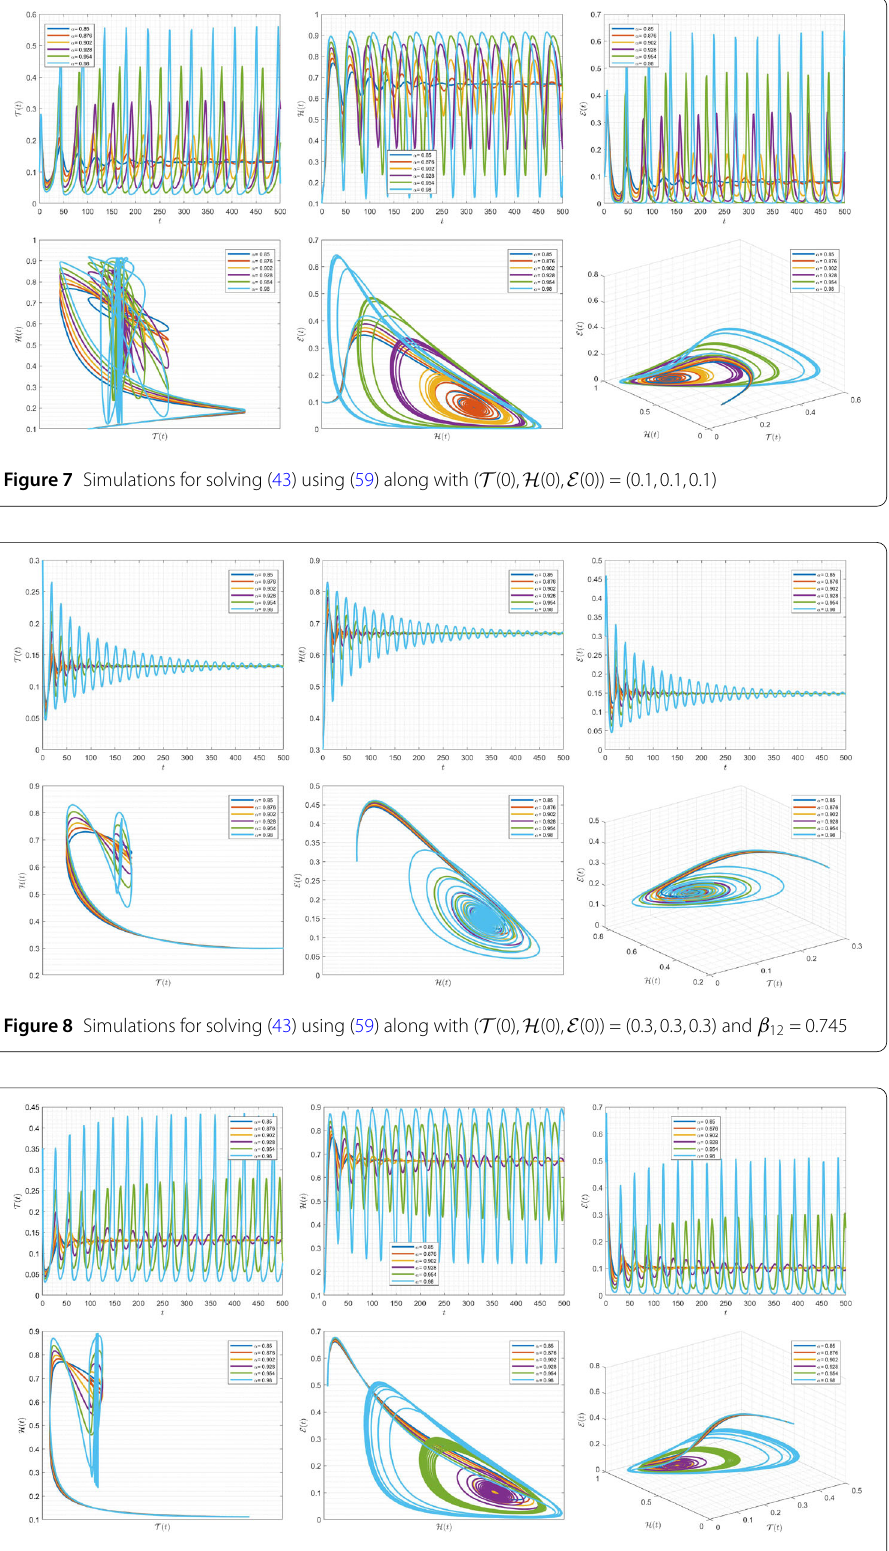
Figure 9 Simulations for solving (43) using (59) along with ( T (0), H (0), E (0)) = (0.3517,0.1115,0.4951) and β 12 =